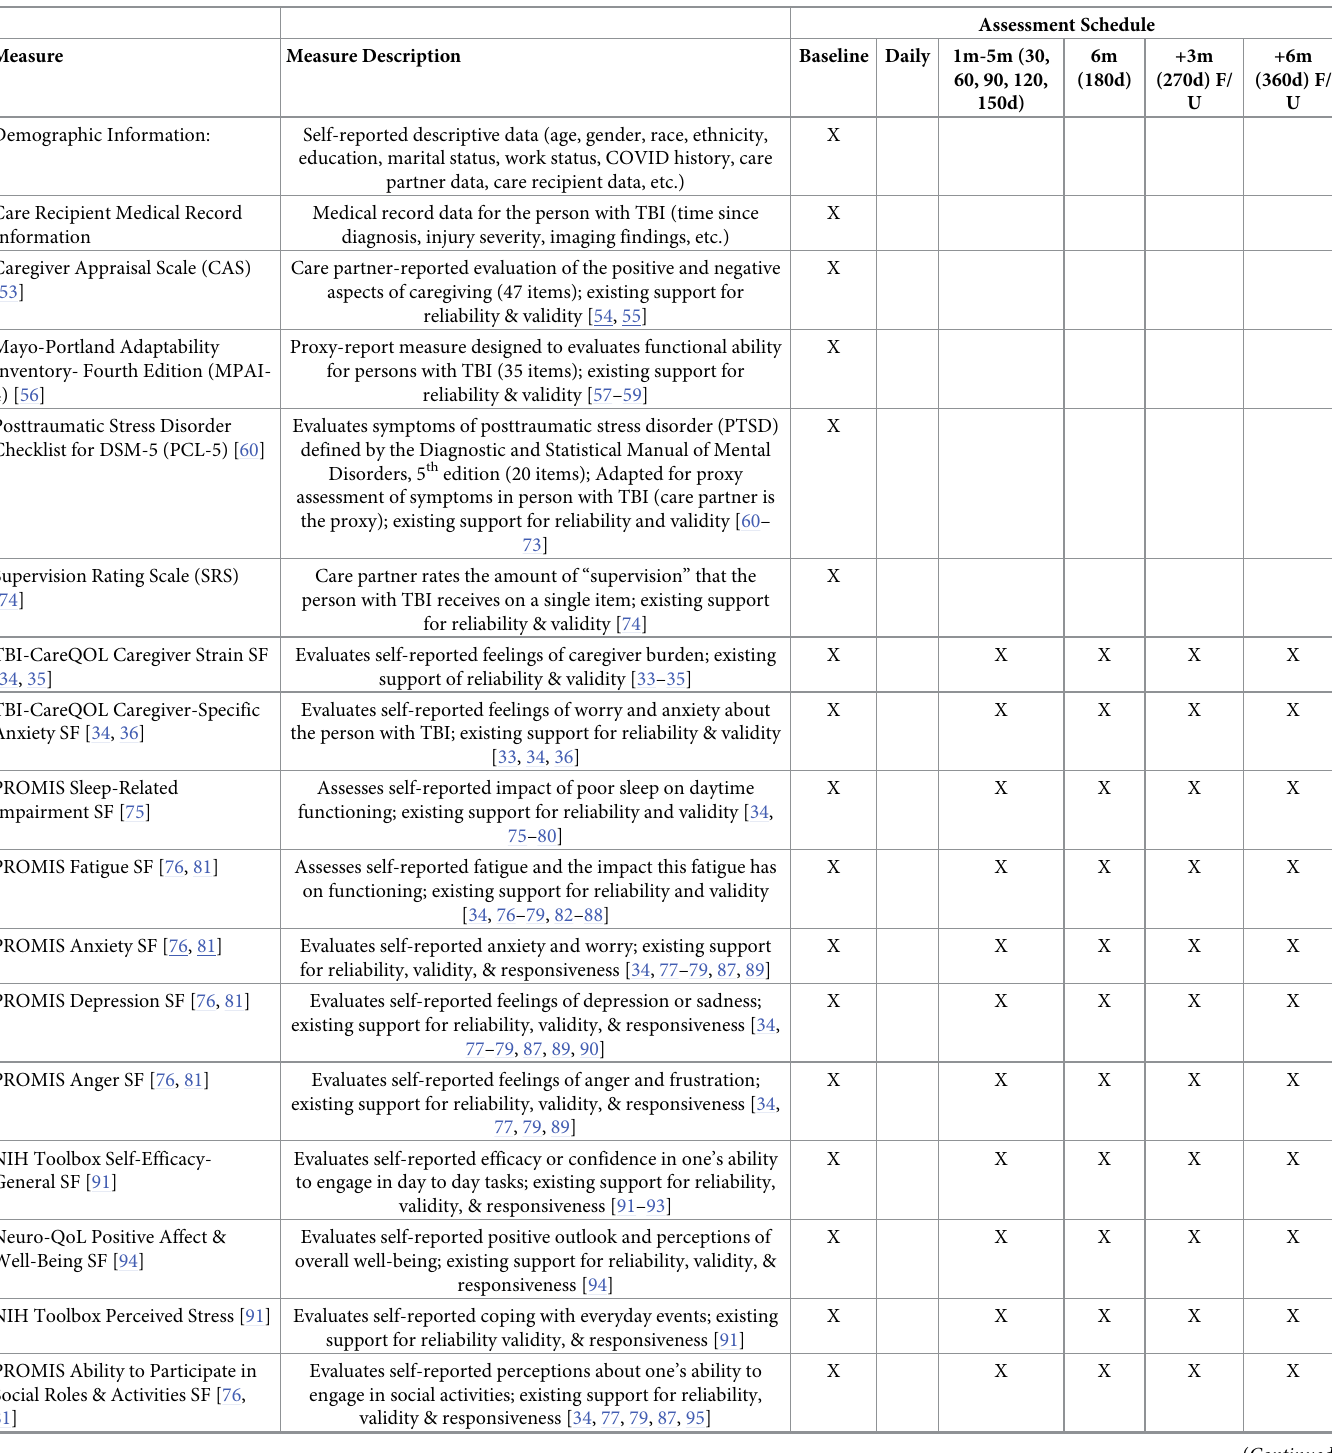
Table 1. Outcome measures and assessment